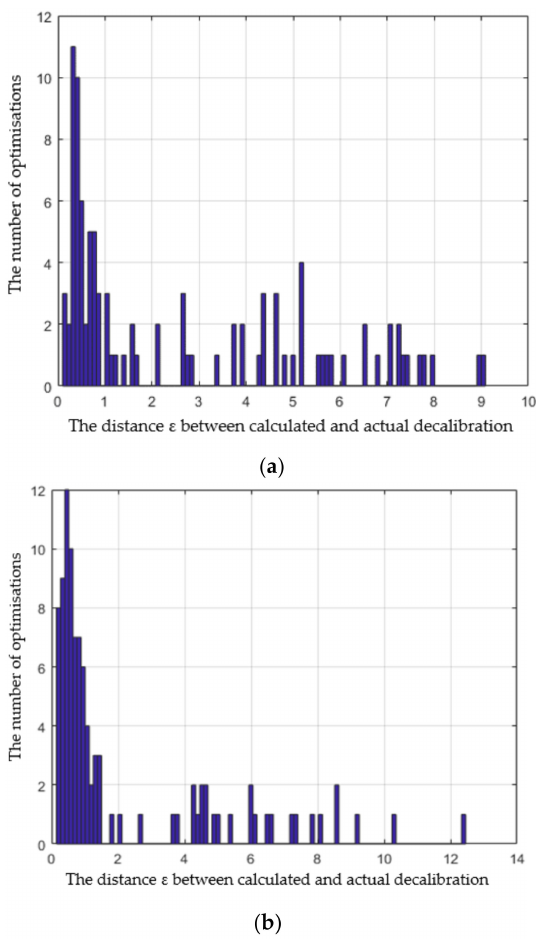
Figure 8. Histogram of distances between the minimum found by the algorithm and the point corresponding to the actual value of decalibration. The goal function was calculated from 50 ( a ) and from 100 ( b )